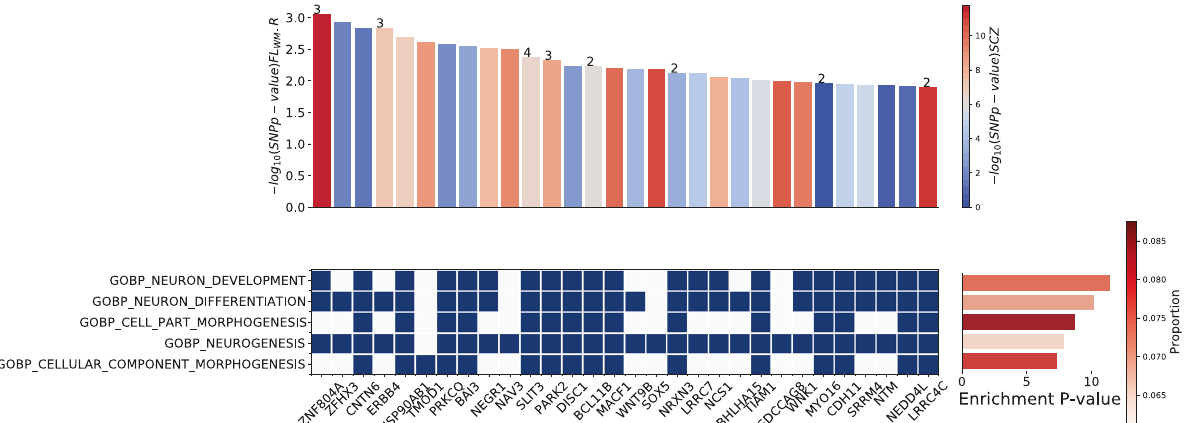
Fig. 4 Top fi ve enriched pathways and their corresponding gene lists as calculated by FUMA [46]. Top: bar plot of – log( p -value) of SNPs mapped to genes in gene list ordered by their association with the right frontal lobe white matter in the European cohort. Numbers on the bar denote the number of SNPs if more than 1 SNP associated with right frontal lobe white matter is mapped to that gene. Colours in the bar plot denote the – log( p -value) of the SNPs (the most associated SNP if there are more than 1 for that corresponding gene) with schizophrenia as calculated by schizophrenia GWAS [21]. Bottom: Enriched gene sets and their overlapping gene list (shown are the top 30 genes ordered by their p -value association with the right frontal lobe white matter). Blue square- the gene in the gene list is present in that pathway. Left: bar plot of the gene-set enrichment adjusted p -value. Colours denote the proportion of genes in the gene set found in the gene list. GO_BP – Gene Ontology Biological Processes.